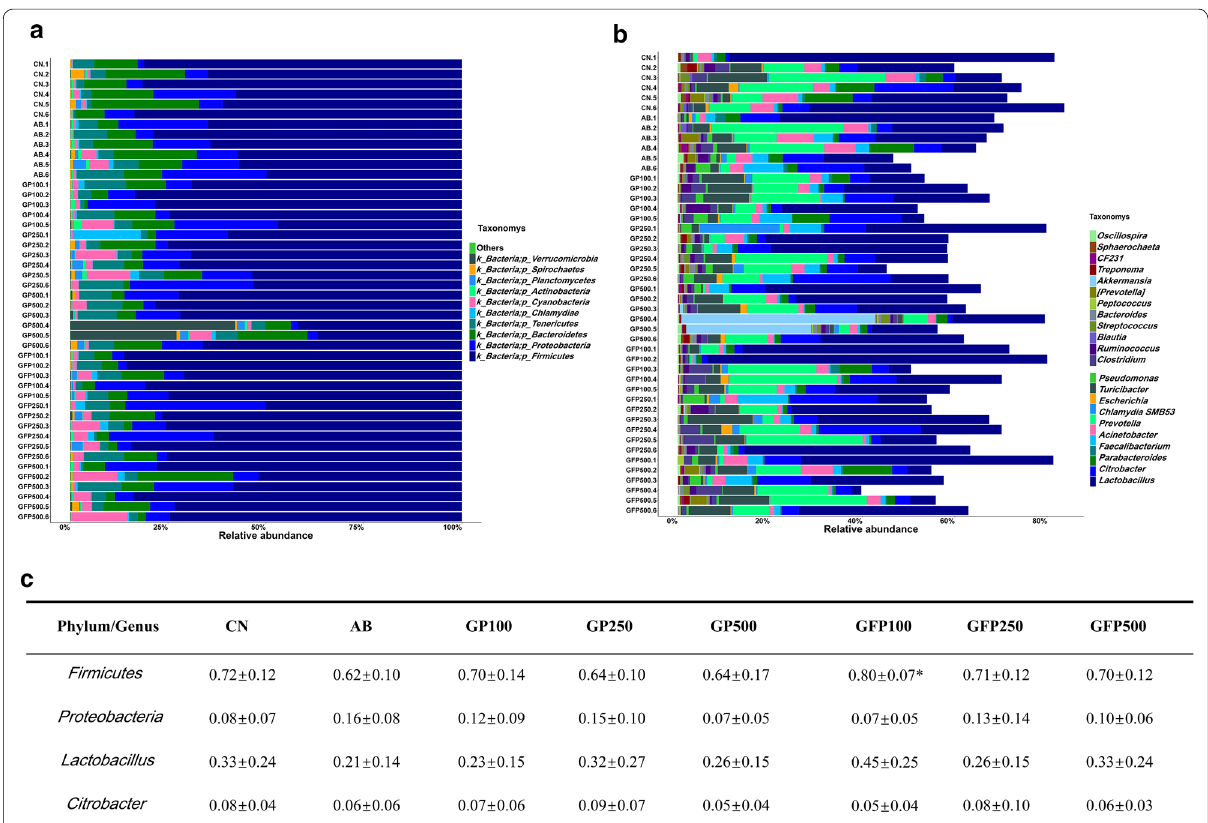
Fig. 2 Composition of bacterial communities after XOS supplementation used at different concentrations in pigs at different stages of development. a Relative contribution of the top 10 phyla in each sample. b Relative contribution of the top 23 genera in each sample. c Mean relative abundance of the phyla Firmicutes and Proteobacteria and the genera Lactobacillus and Citrobacter . GFP100 group compared with antibiotic group, * P <